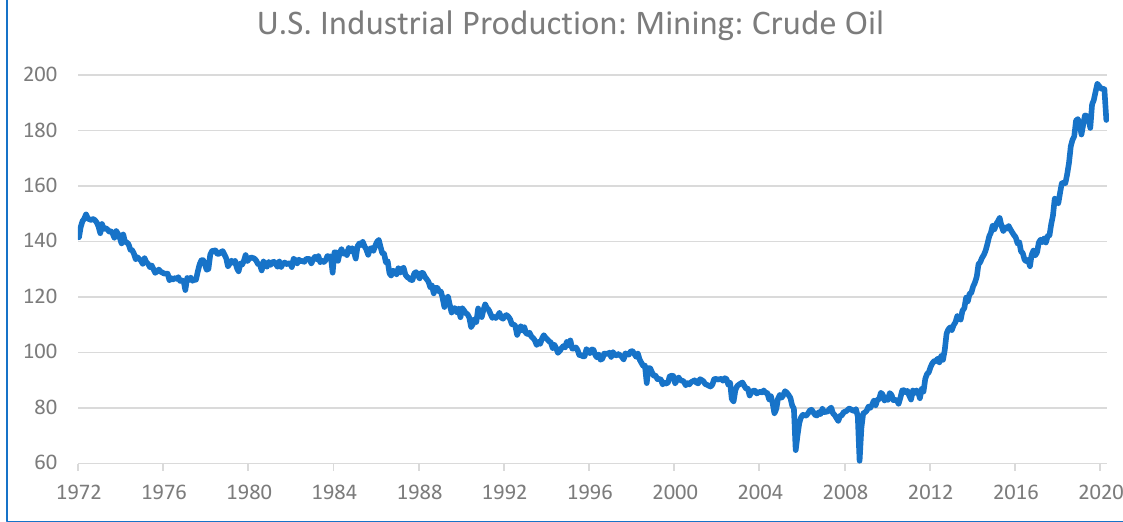
Figure 1. Oil production.